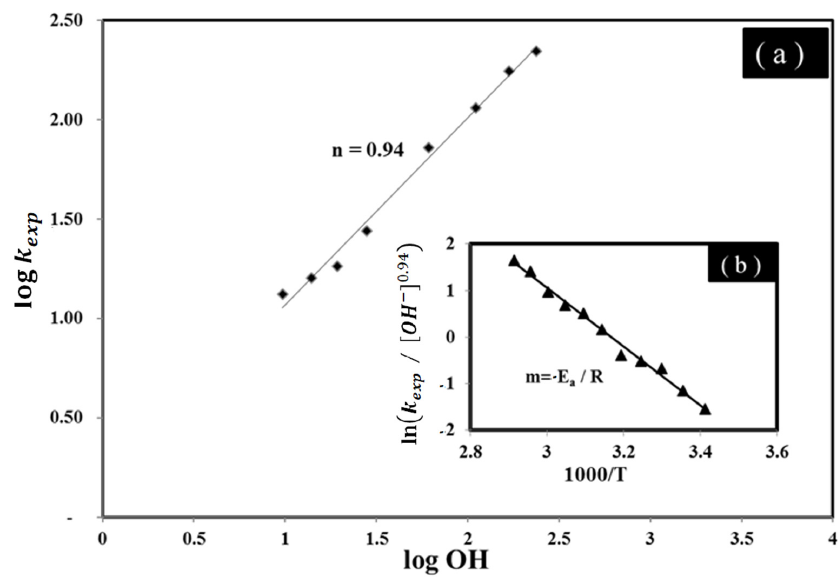
Figure 11. ( a ) Dependence of k exp on OH − concentration for the decomposition of ammonium-sodium jarosite with arsenic in NaOH media. ( b ) Dependence of k exp on temperature, E a = 51.6 kJ/mol in NaOH media. Table 6. Kinetic parameters calculated for the decomposition of ammonium-sodium jarosite with arsenic in NaOH media.